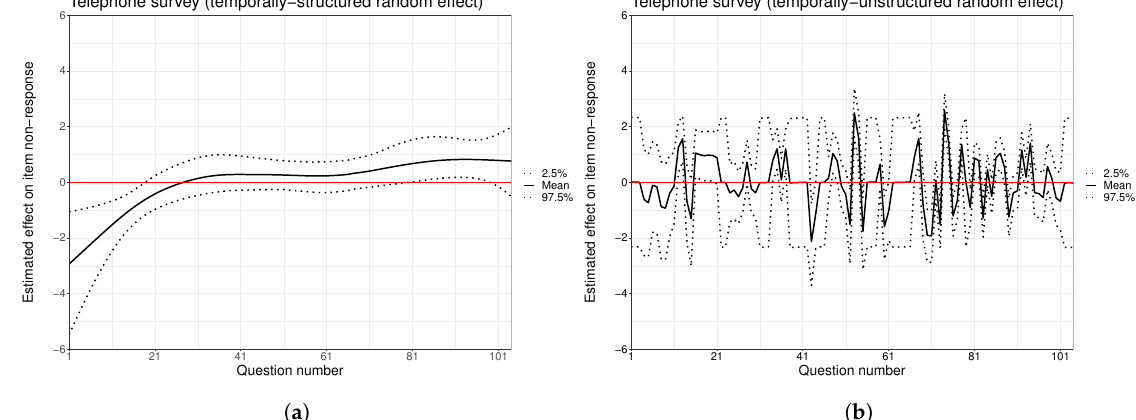
Figure 4. Estimation of the structured ( a ) and unstructured ( b ) temporal random effects considered for modeling item non-response values in the telephone survey. These estimates correspond to ˆ γ j ( a ) and ˆ φ j ( b ) according to Equation